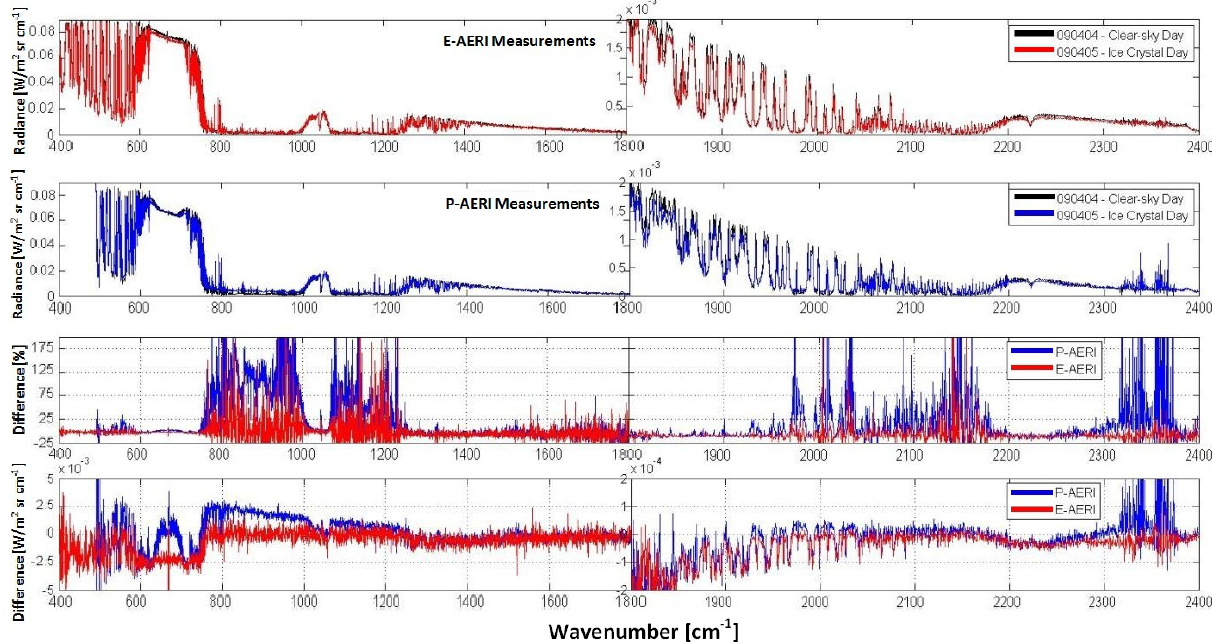
Fig. 11. Radiance measurements for 4 April 2009 (00:08–00:18UTC) and 5 April 2009 (20:30–20:40UTC) for the E-AERI (top panel) and P-AERI (second panel). Bottom two panels are differences between the ice crystal and clear-sky radiances, given as a percentage (ice crystal-clear sky/clear sky) and in radiance for both instruments, respectively.